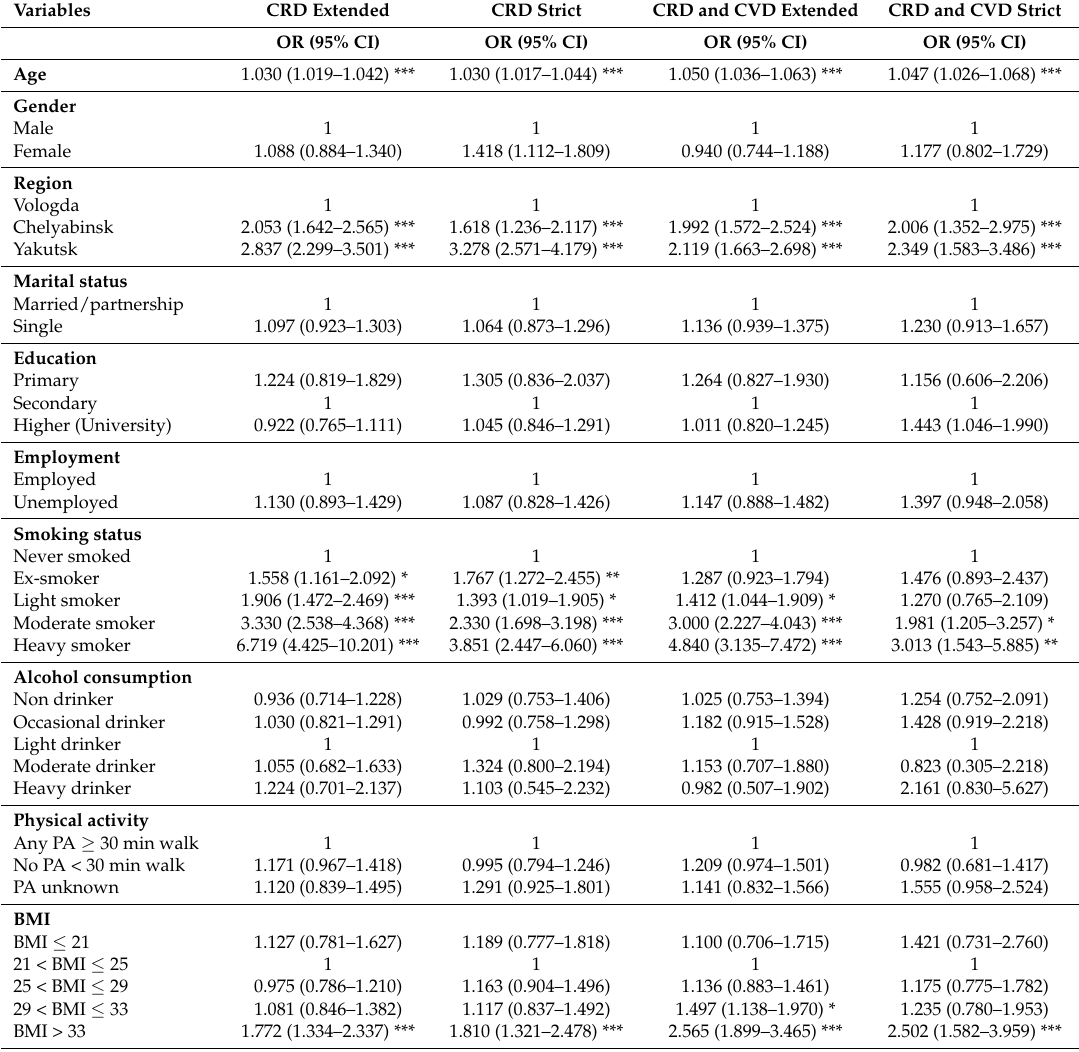
Table 3. The association of the risk factors with COPD/cardiorespiratory categories that based on the results of multivariate logistic regression